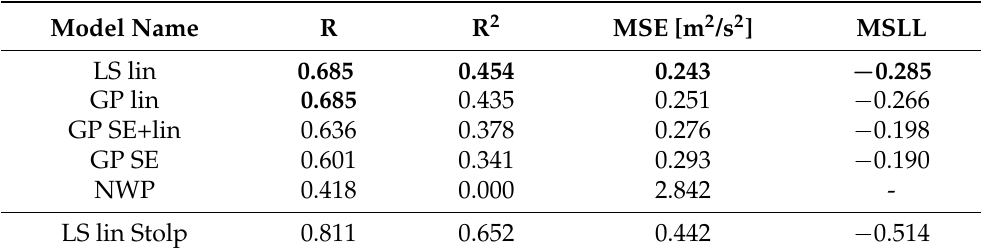
Table 3. Figures of merit for various models of wind speed at Brežice meteorological station and for LS lin model at Stolp meteorological station. The values given are the values obtained on the test data averaged over the 12 models with different train/test data set selections and the Brežice models are ordered in ascending MSE.